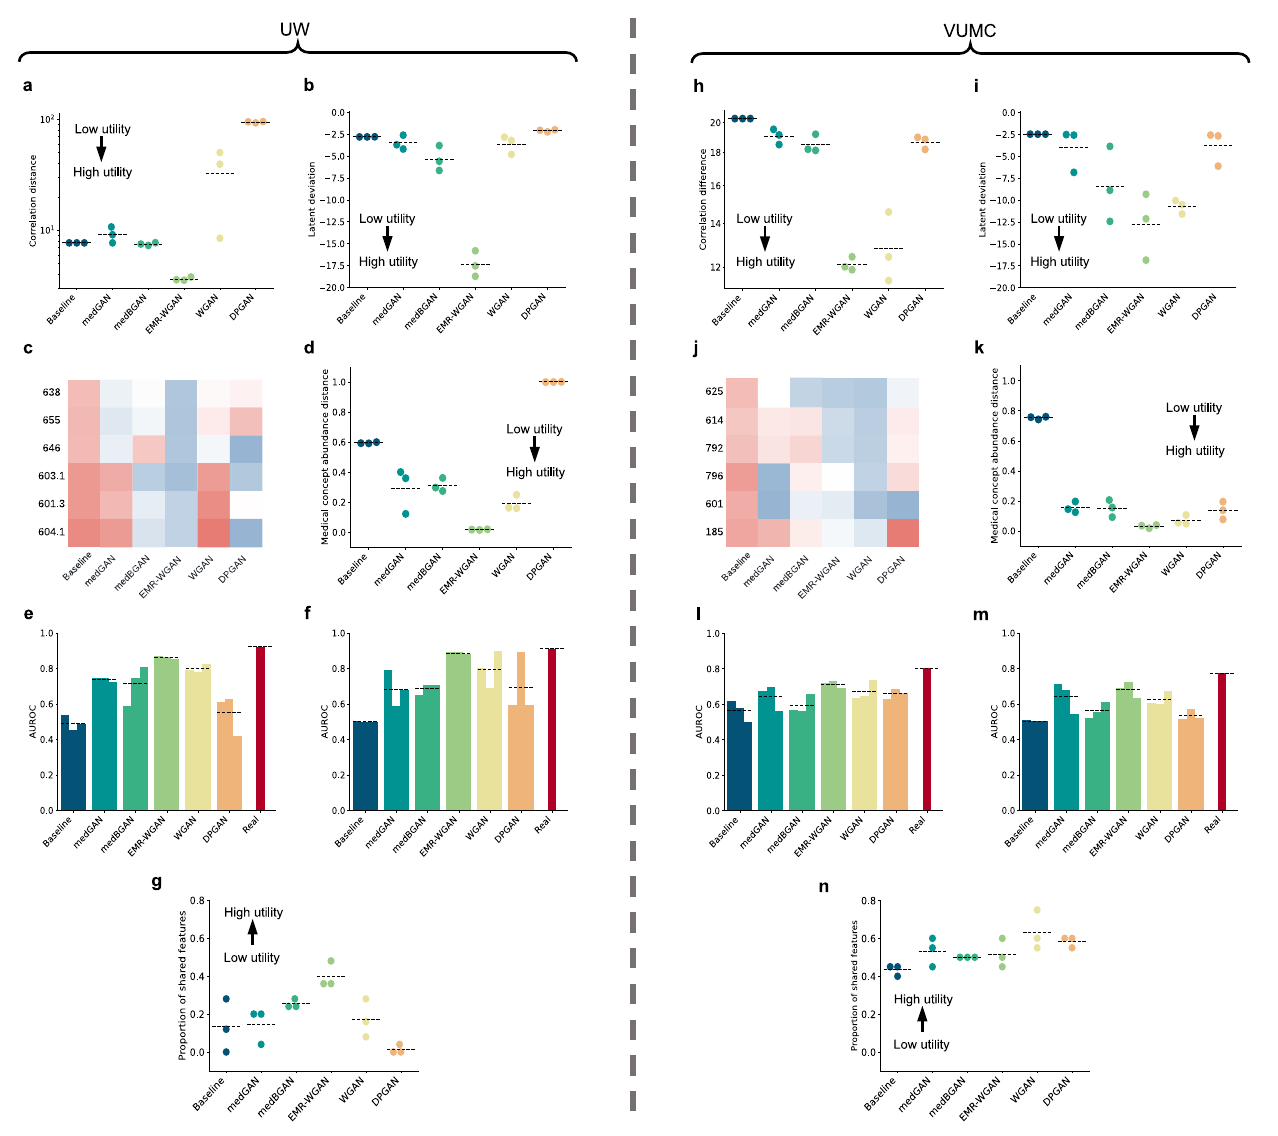
Fig. 3 | Data utility for the UW (a – g) and VUMC (h – n) datasets. a , h Column-wise correlation. b , i Latent cluster analysis. c , j Clinical knowledge violation for gender- speci fi cphecodes. d , k Medicalconceptabundance. e , l TSTRModelperformance. f , m TRTSModelperformance. g , n Theproportionoftop k featuresincommon(25for UW and 20 for VUMC). The heatmaps correspond to the ratio of clinical knowledge violations in gender (blue = low value; red = high value). A dashed line indicates the mean value across three synthetic datasets. (Phecode: 625: Symptoms associated with female genital organs; 614: In fl ammatory diseases of female pelvic organs; 792: AbnormalPapanicolaousmearofcervixandcervicalHPV;796:Elevatedprostate-speci fi cantigen;601:In fl ammatorydiseasesofprostate;185:Prostatecancer;638:Other high-risk pregnancy; 655: Known or suspected fetal abnormality; 646: Other complications of pregnancy NEC; 603.1: Hydrocele; 601.3: Orchitis and epididymitis; 604.1: Redundant prepuce and